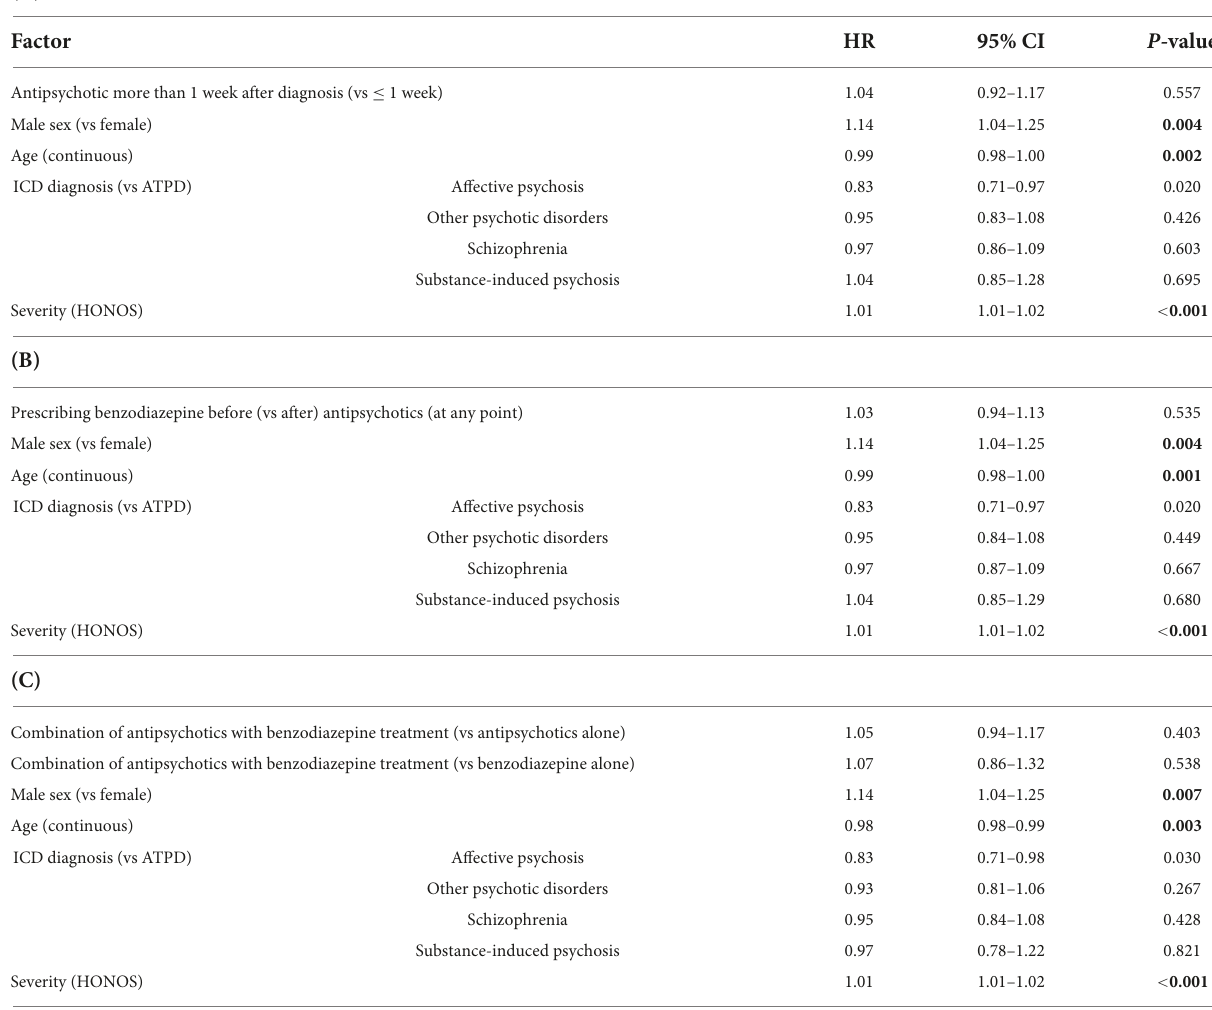
TABLE 2 Adjusted multivariable Cox regression results. The primary outcome (risk of any psychiatric inpatient admission over 6 years after FEP diagnosis) was tested for the effect of (A) antipsychotic timing (subjects = 3,834, 2,128 admissions), (B) prescribing benzodiazepine before antipsychotics (subjects = 3,834, admissions = 2,128), and (C) treatment patterns within the first week after FEP ( n = 3,512, admissions =